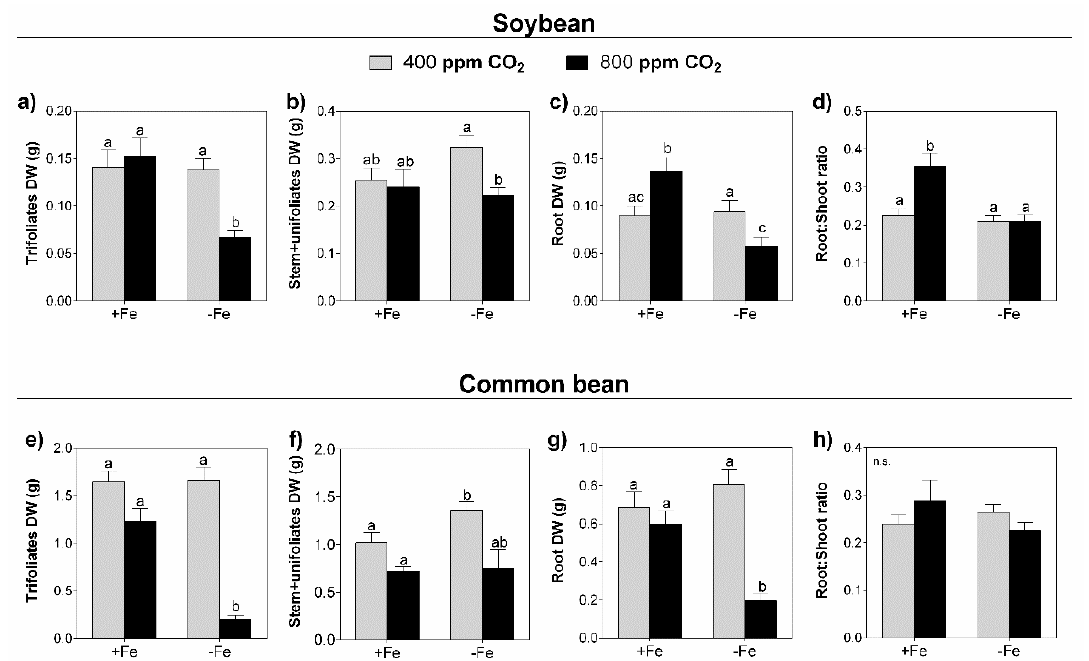
Environments 2021 , 8 , x Figure 1. Trifoliate ( a , e ), stem+unifoliate ( b , f ), root ( c , g ) and root:shoot ratio ( d , h ) of soybean and common bean plants grown at 400 ppm and 800 ppm CO 2 and with 0 ( − Fe) and 20 µ M Fe-EDDHA (+Fe). The results represent the mean of five biological replicates ± SE. Different letters above bars indicate significant differences p < 0.05 using the Tukey test.